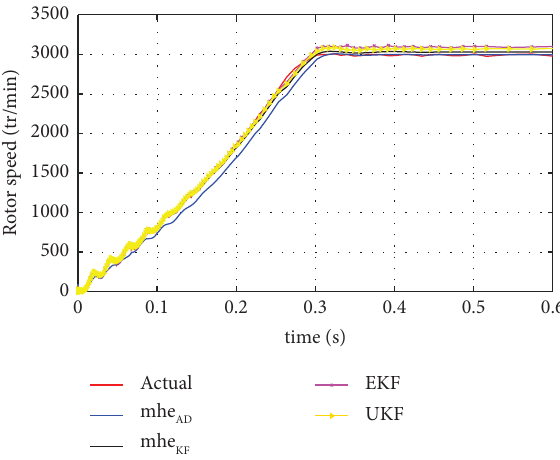
Figure 5: Estimation of rotor speed.